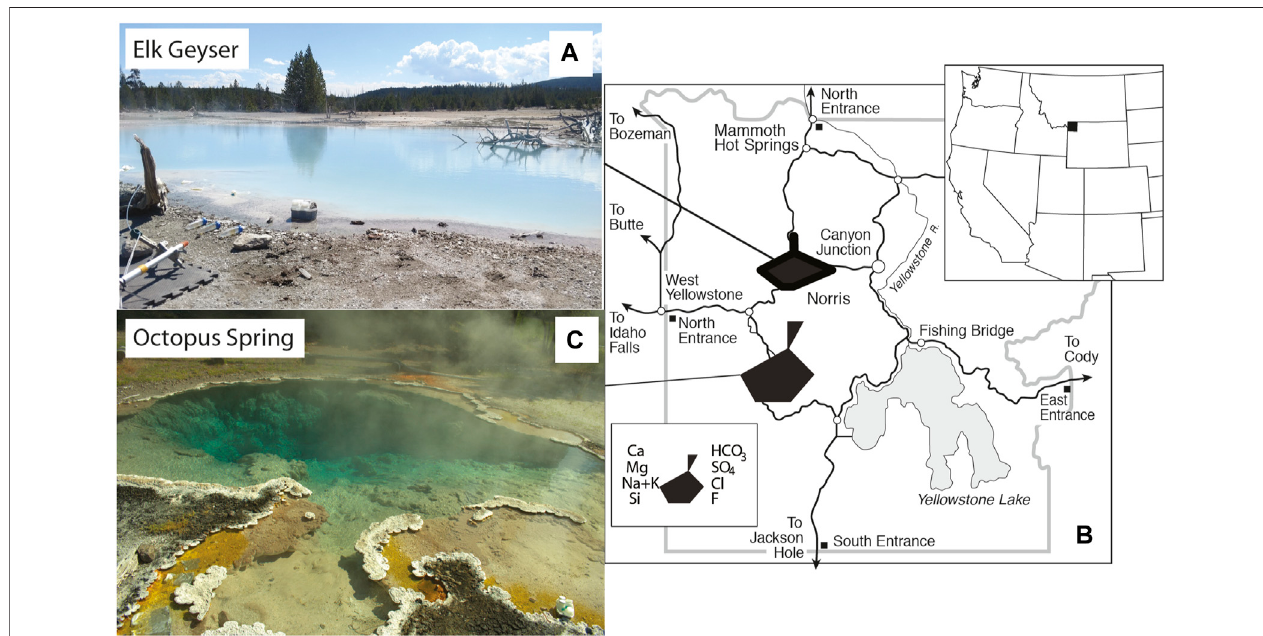
FIGURE2| ImagesandlocationofYellowstoneNationalPark,WY,UnitedStateswithinthewesternUnitedStates. (A) .LocationofYellowstoneNationalPark,WY, UnitedStates. (B) .LocationmapofstudysiteswithinYellowstoneNationalPark,WY,UnitedStateswithwaterchemistryrepresentedbyStiffdiagrams. (C) .ImageofElk Spring. (D) . Image of Octopus